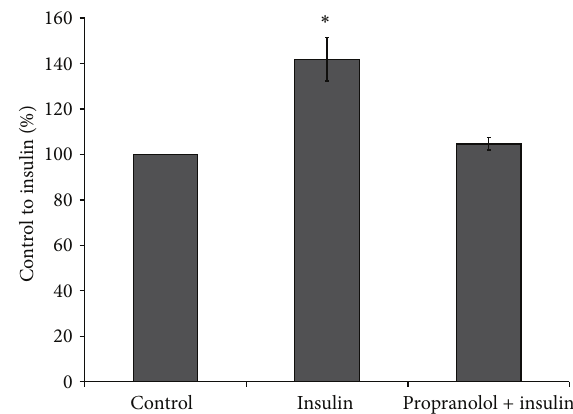
Figure5:Effectofpropranololoninsulin-stimulatedglucoseuptake by isolated hepatocytes. Insulin-stimulated glucose uptake and propranololtreatmentsweredoneasdescribedintheMethods. ∗ 𝑝 < 0.05 , insulin versus